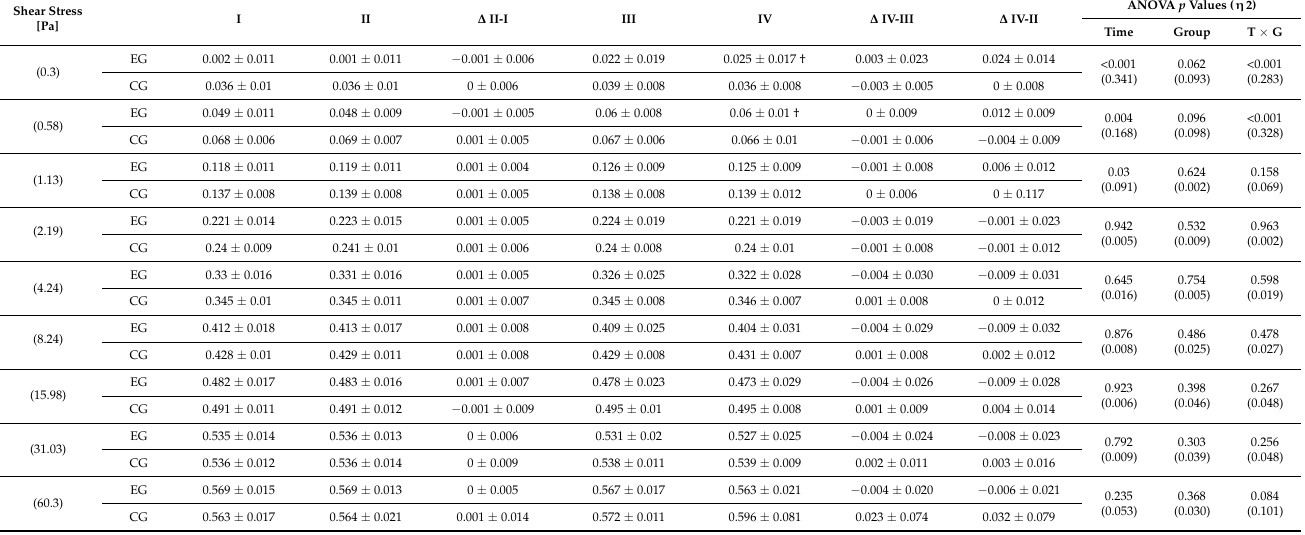
Table 4. Changes in elongation index (EI) at various levels of shear stress after a single bout of exercise in experimental (EG) and comparison group